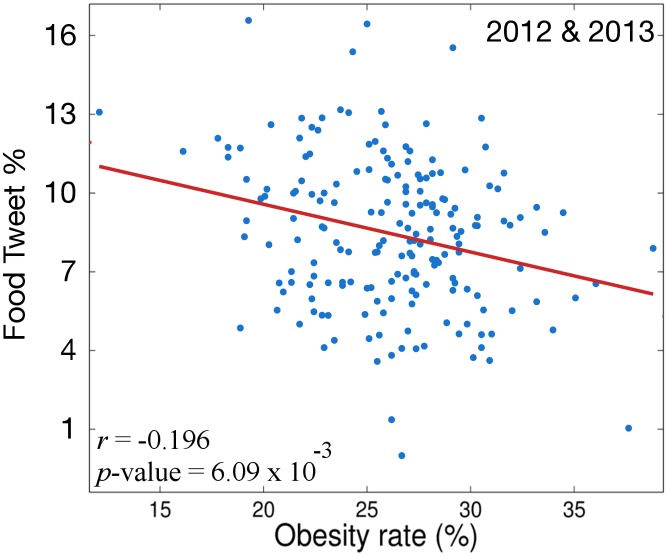
Correlation of FT% and BMI over all MSAs for 2012 & 2013.